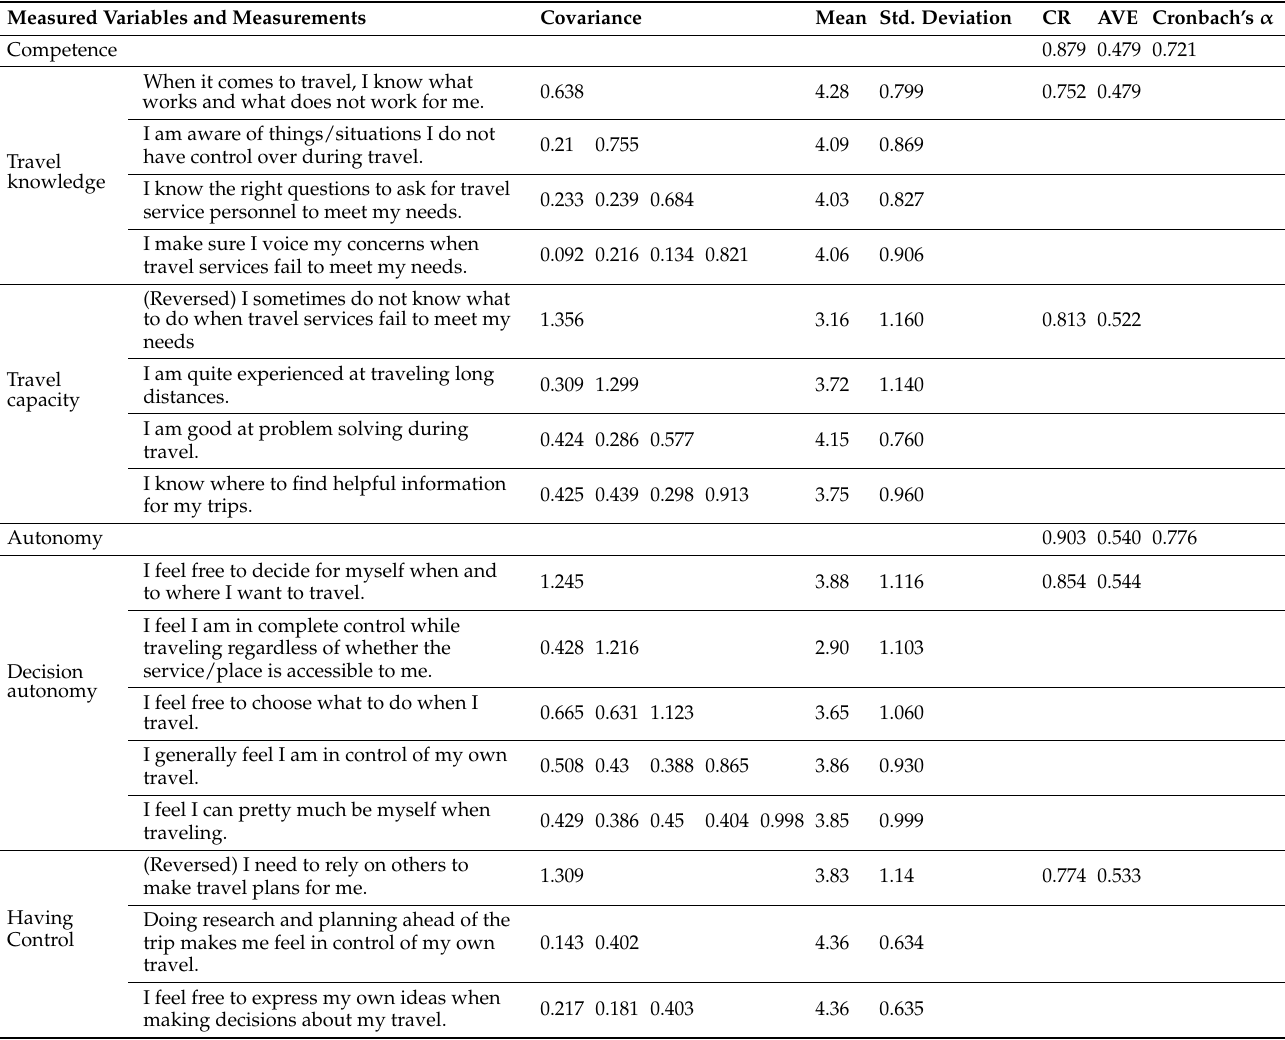
Table 2. Descriptive Statistics and Covariance Matrix of